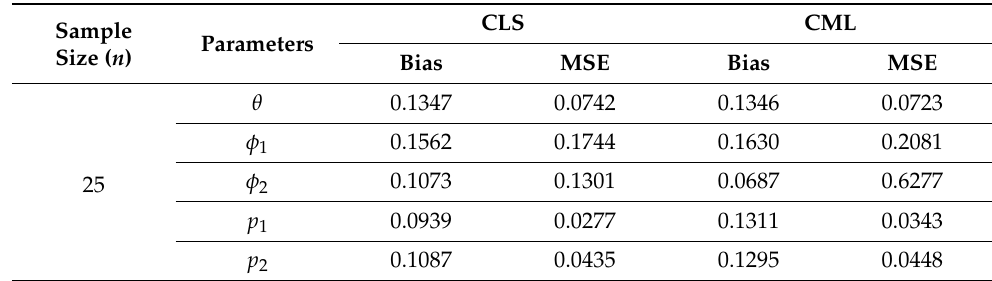
Table 4. Simulation results for the BINAR(1)BP2S-L(I) process for the set of parameter